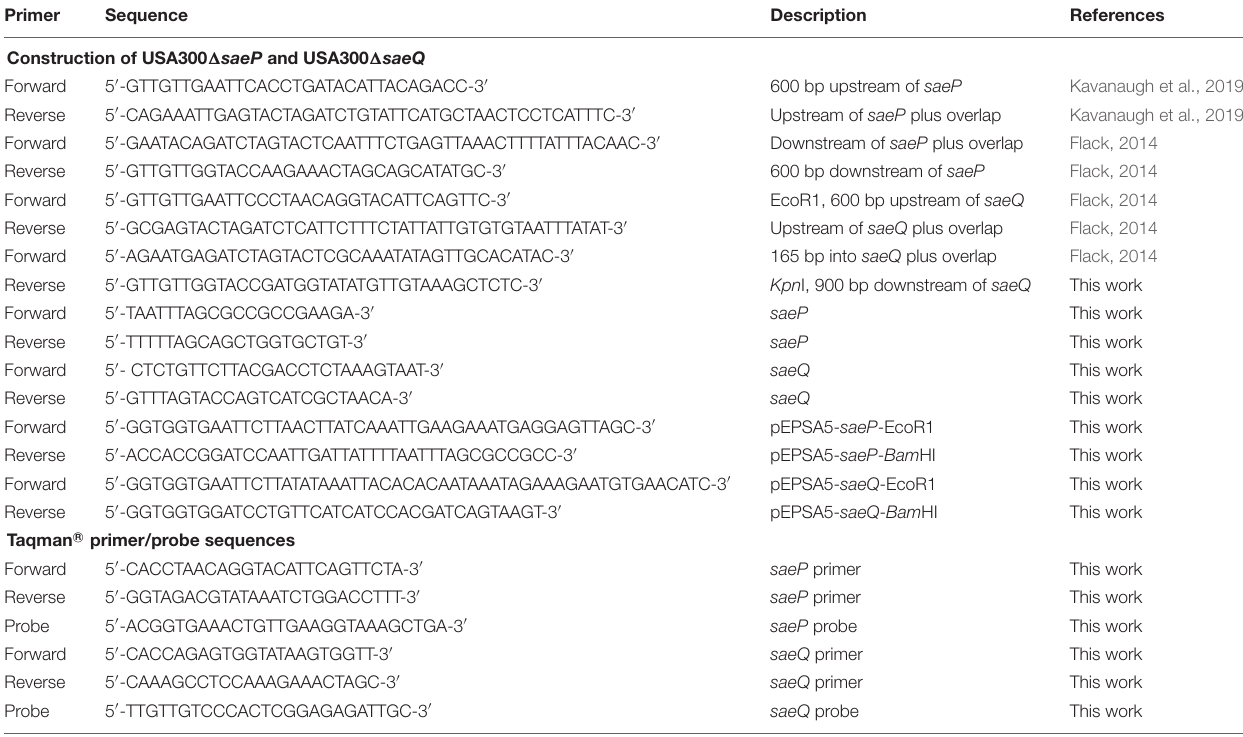
TABLE 1 | Primers used to generate S. aureus mutant strains, respective complemented strains, and TaqMan R (cid:13) primer and probe sequences. Primer